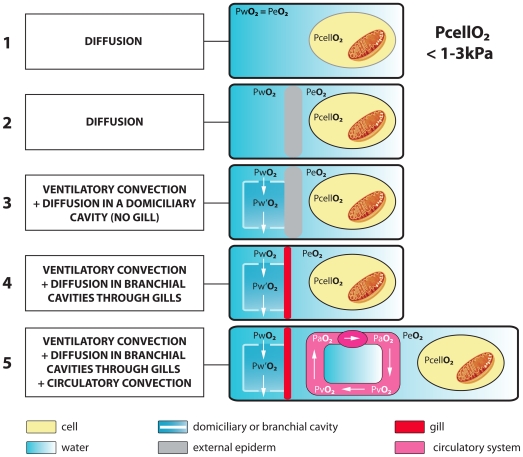
Respiration in water-breathers from simple gaseous diffusion (1) to ventilatory and circulatory convection (5).PwO2, PeO2, PcellO2, Pw′O2, PaO2, PvO2 correspond to the partial pressure of oxygen in water, in the extracellular medium, at cell level, within external chamber (e.g. branchial chamber), in arterial hemolymph, and in venous hemolymph. Today, the PO2 in the blood and tissues of water-breathing animals (see [4] for a review), is remarkably low, ranging between 1 and 3 kPa and is largely independent of ambient PO2. PcellO2 results from the equilibrium between O2 supply and O2 consumption (90% by mitochondria). PwO2>Pw′O2>PaO2>PeO2>PcellO2.